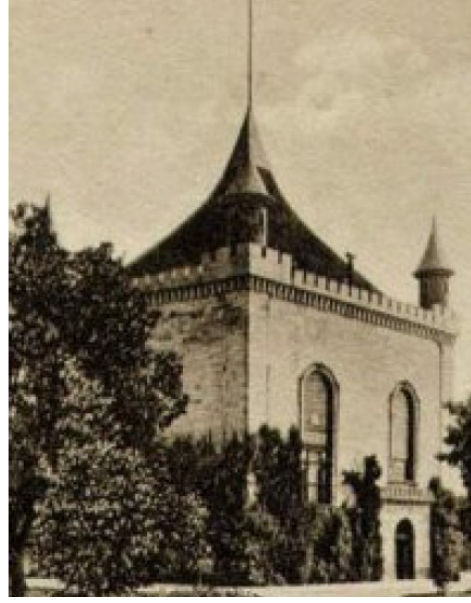
Figure 1. Tower covered by the pagoda-roof and adorned with battlements depicting the reconstruction after the year 1848 (Gemeinde Holle (a))